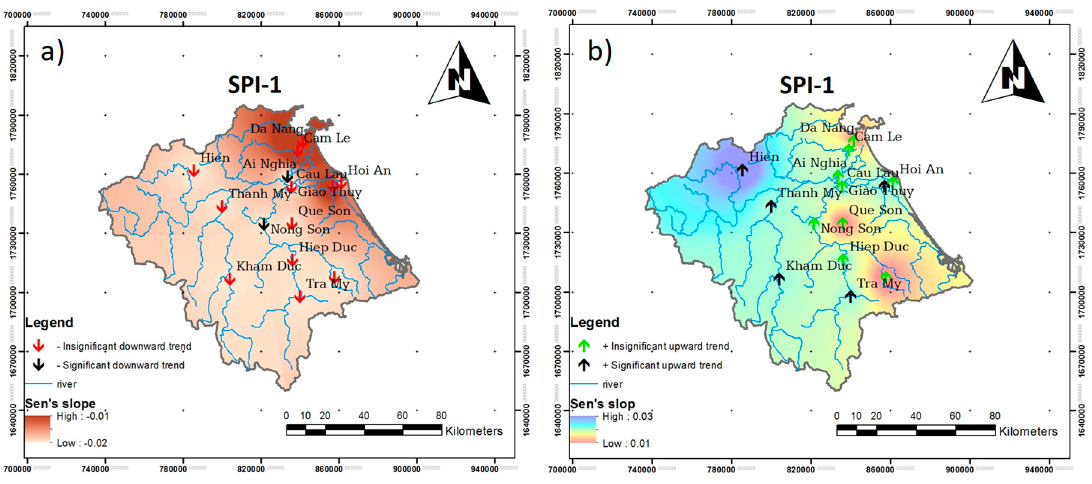
Figure 6. Spatial distribution of Sen’s slope in February ( a ) and in November ( b ) for SPI-1 index.